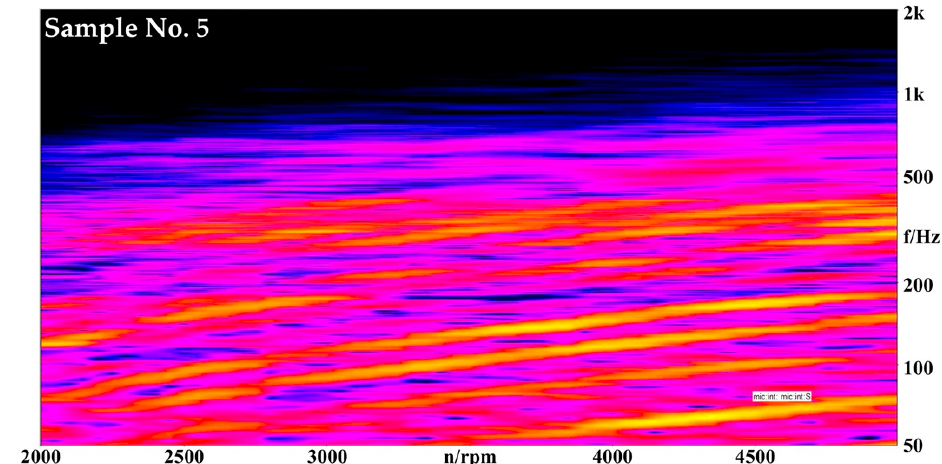
Figure 5. Results of spectrum analysis for samples with the highest (upper side) and lowest (lower side) score of perceived refined.